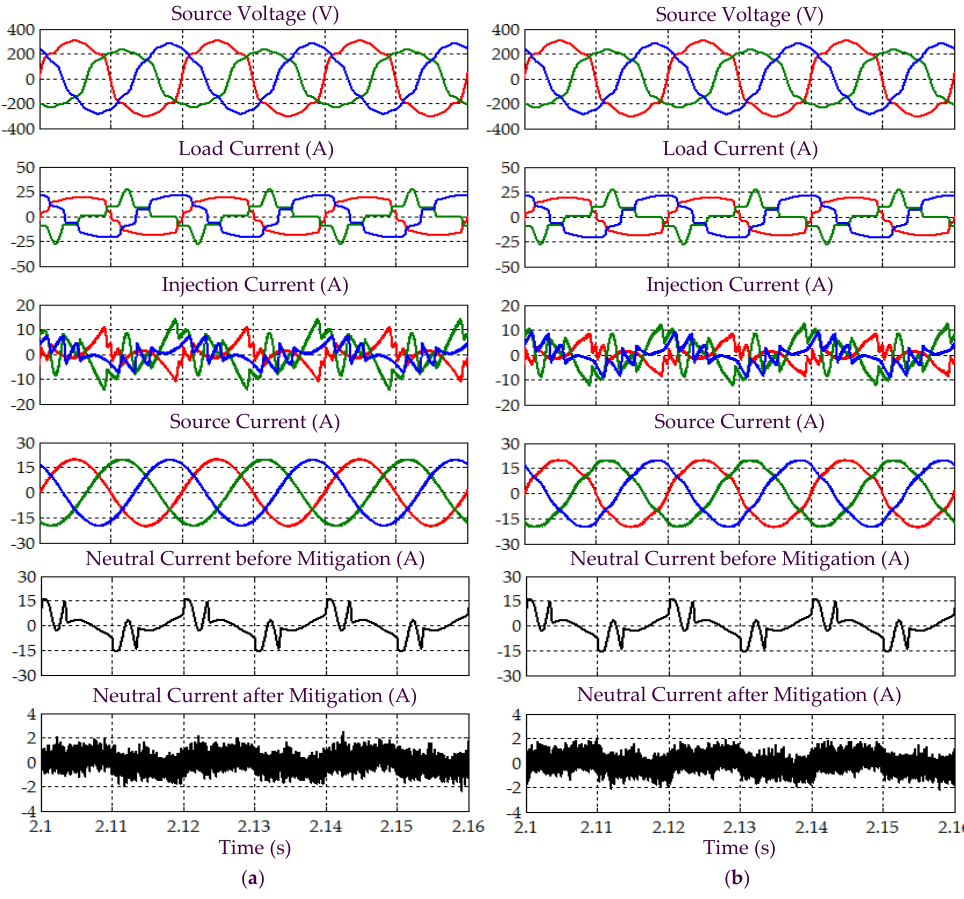
Figure 23. Simulation results obtained under Scenario D for Load 2, which include three-phase source voltage 𝑣 𝑆𝑎𝑏𝑐 , load current 𝑖 𝐿𝑎𝑏𝑐 , injection current 𝑖 𝑖𝑛𝑗𝑎𝑏𝑐 , source current 𝑖 𝑆𝑎𝑏𝑐 , and neutral current before and after mitigation, demonstrated by SAPF while applying the ( a ) proposed STF- dq 0 and ( b ) standard dq 0 techniques.